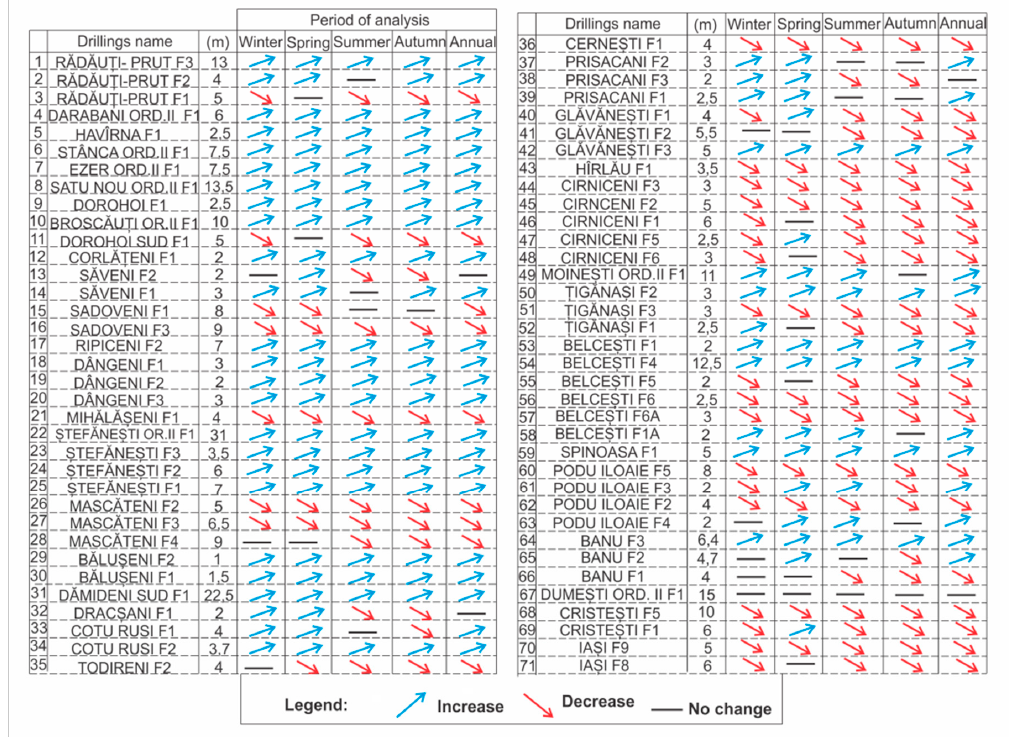
Figure 4. Seasonal and annual trends for groundwater level.